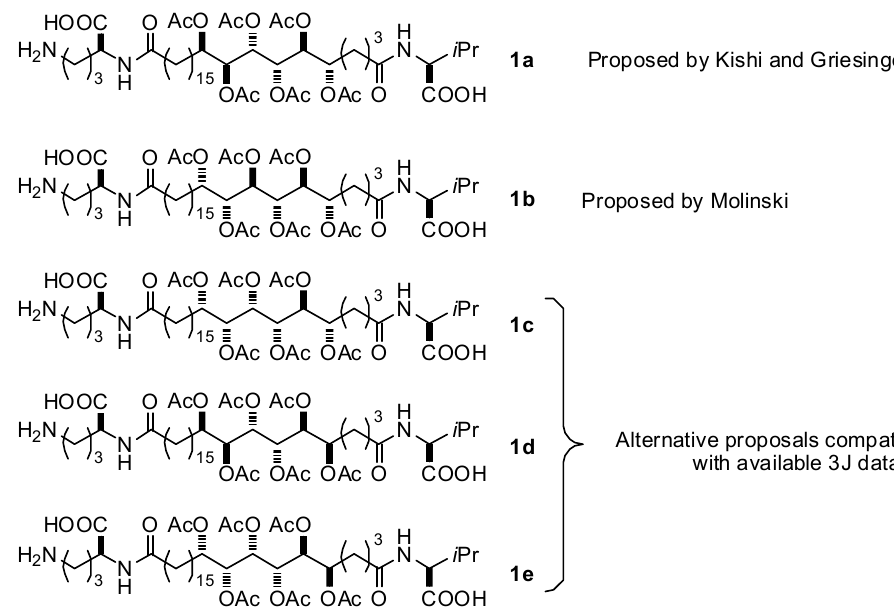
Figure 2. Structures proposed for Sagittamide A 1